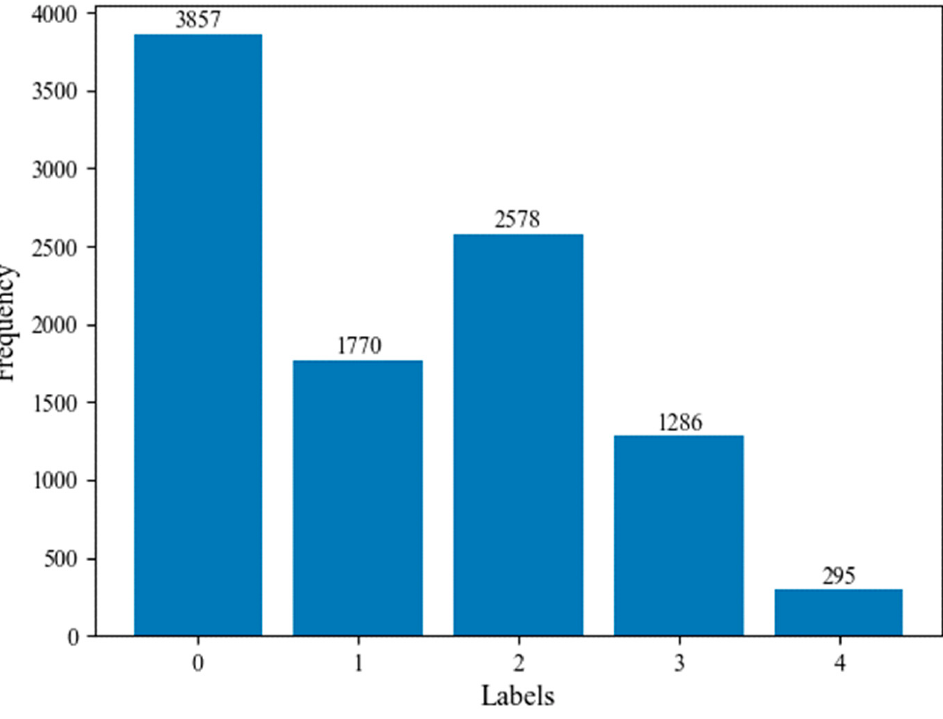
Figure 4. The distribution of instances across the KL grading system for assessing knee OA severity.